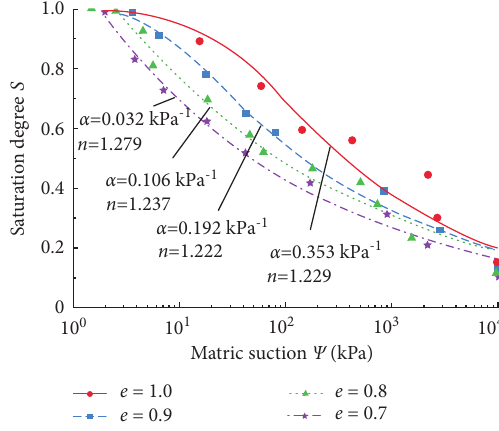
Figure 7: Soil-water characteristic curves at different void ratios. Table 2: Hydraulic properties used in the numerical